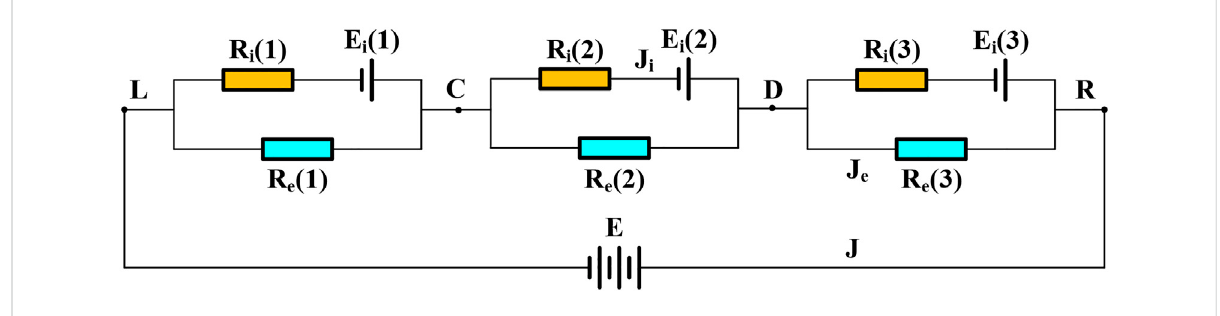
FIGURE 2 Equivalent circuit of the multilayer